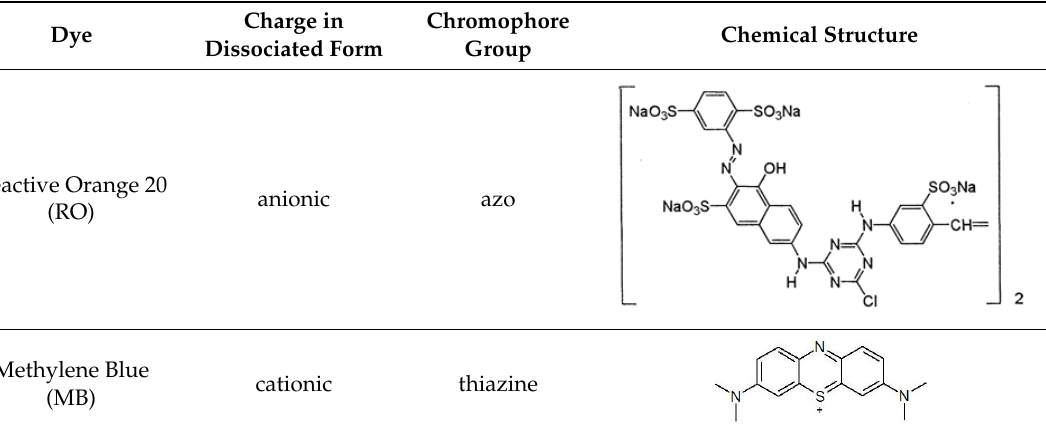
Table 1. Characteristics of dyes.